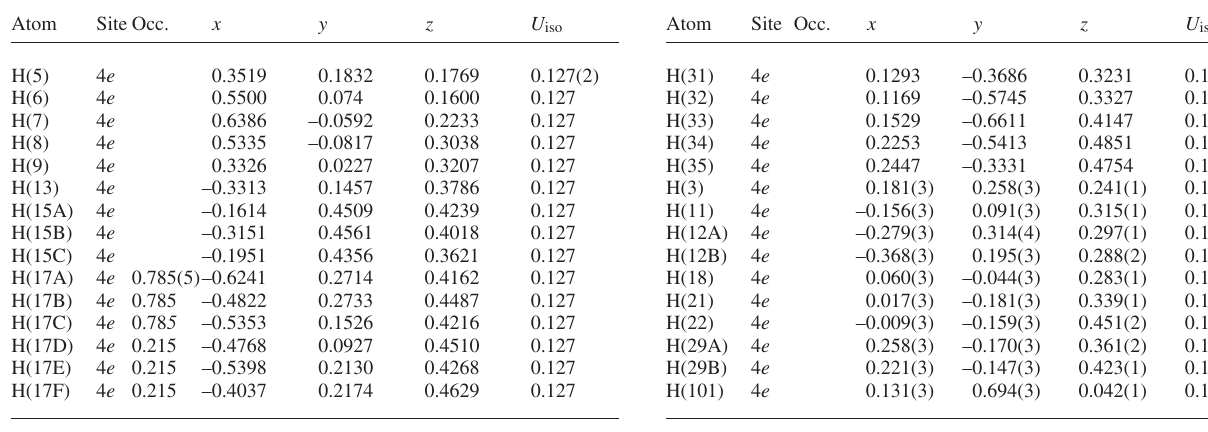
Table 2. Atomic coordinates and displacement parameters (in Å 2 )